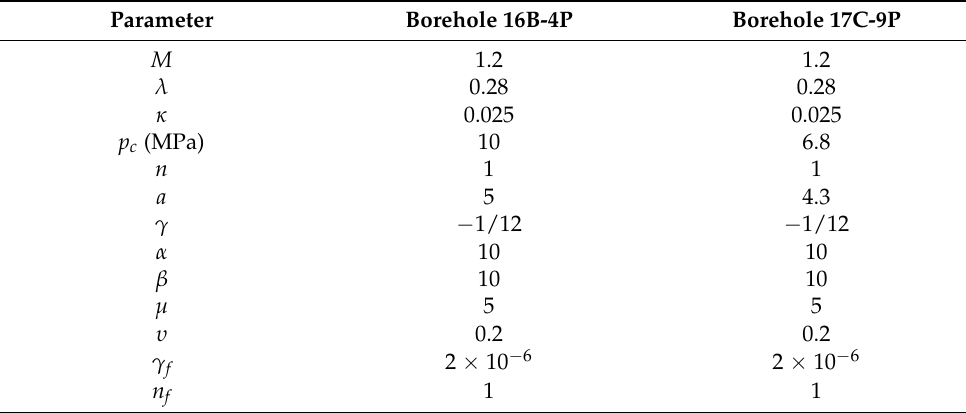
Table A7. Model parameters adopted for Case 3 in Figure